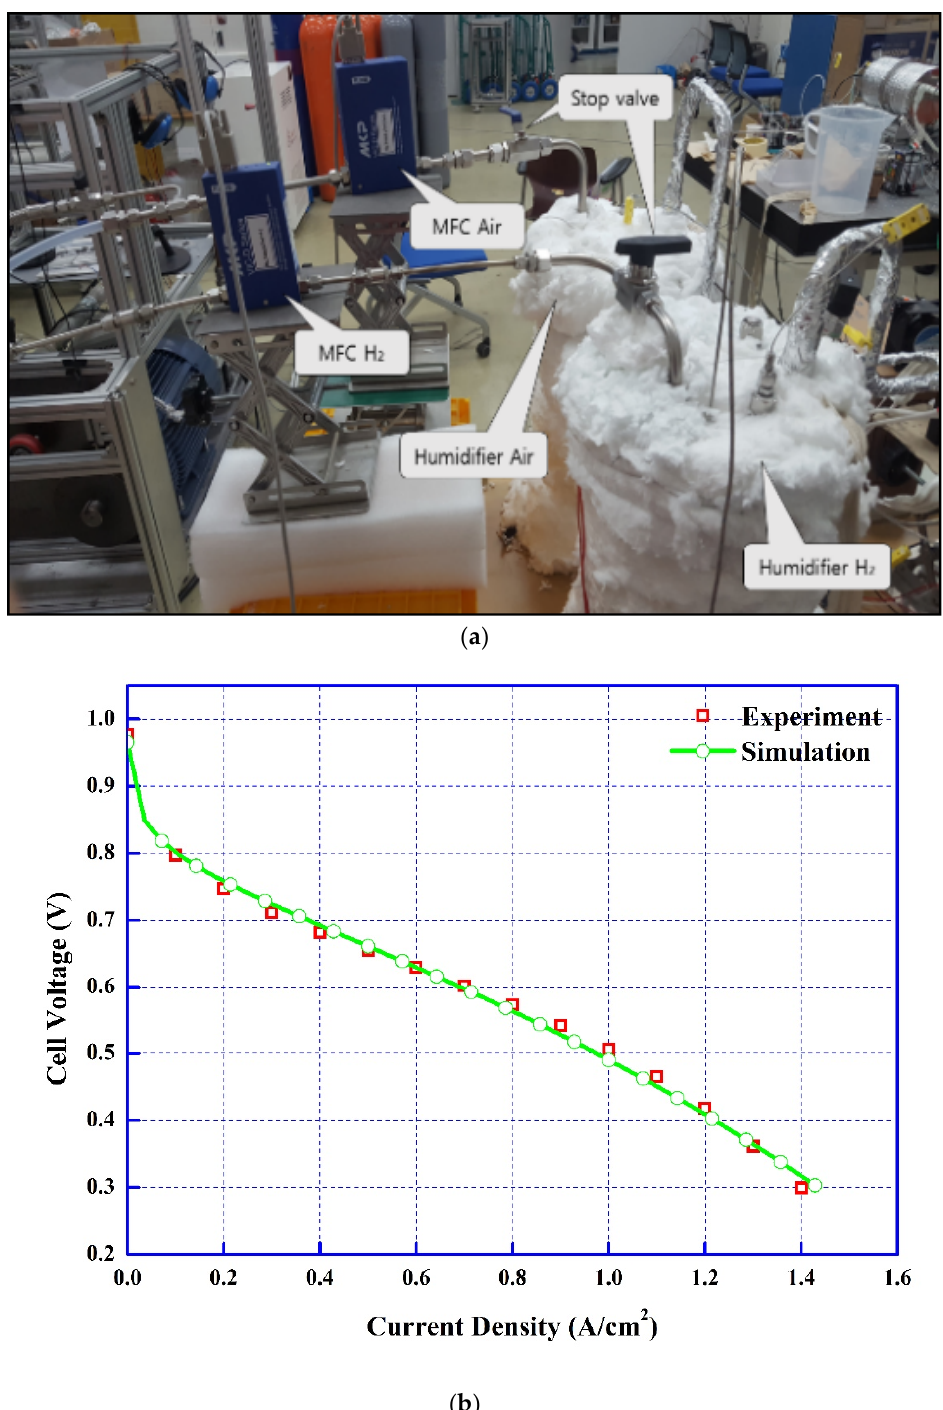
Figure 5. Unit cell test bench and results of validation of I-V curve (( a )—unit cell test bench, ( b )—results of validation of I-V curve with experimental data).